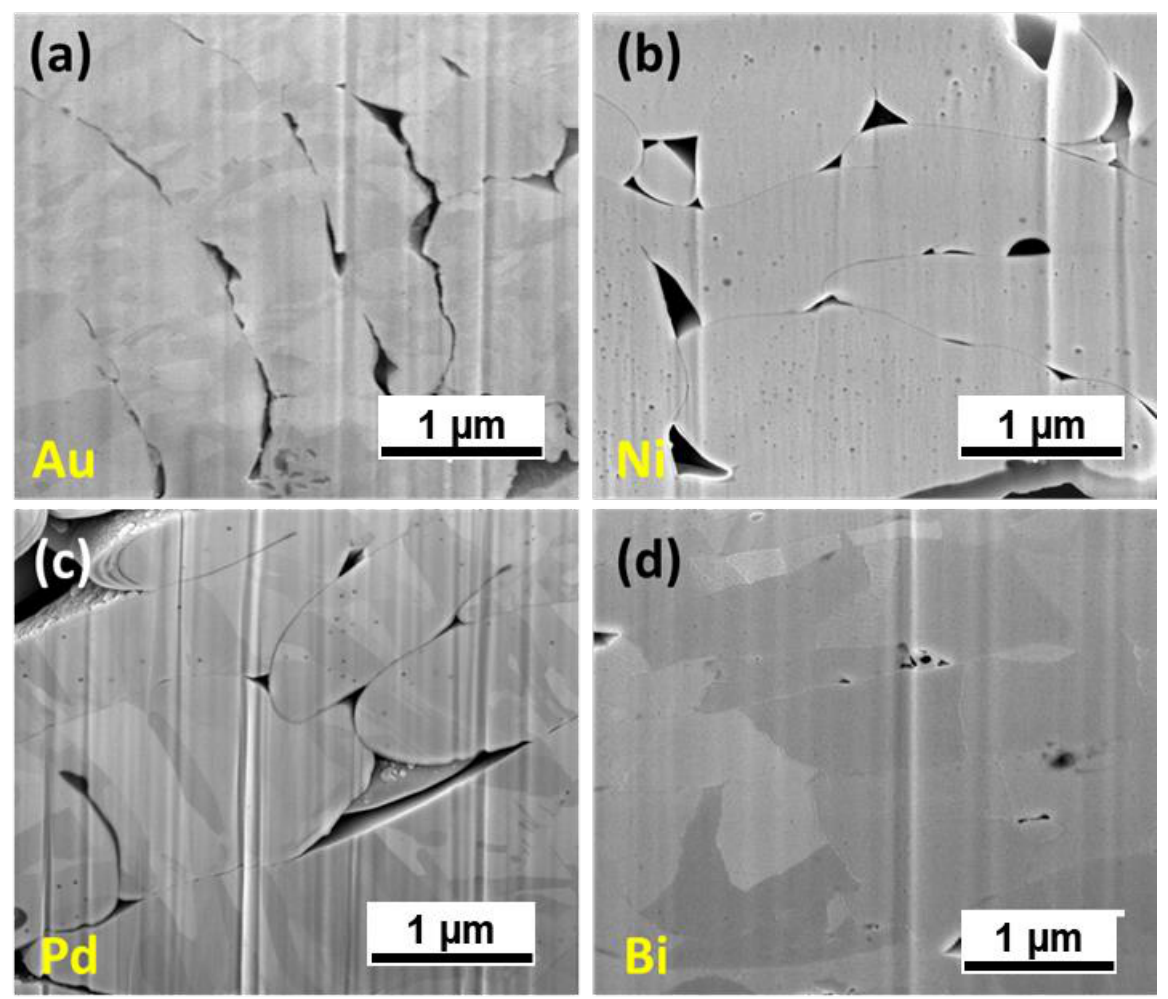
Figure 2. HR-SEM images of focused ion beam (FIB) cross-sections of LIFT printed metal tracks: ( a ) gold; ( b ) nickel; ( c ) palladium, and ( d ) bismuth. The highly compact structure of Bi printing is noticeably superior to other metals in terms of compactness and